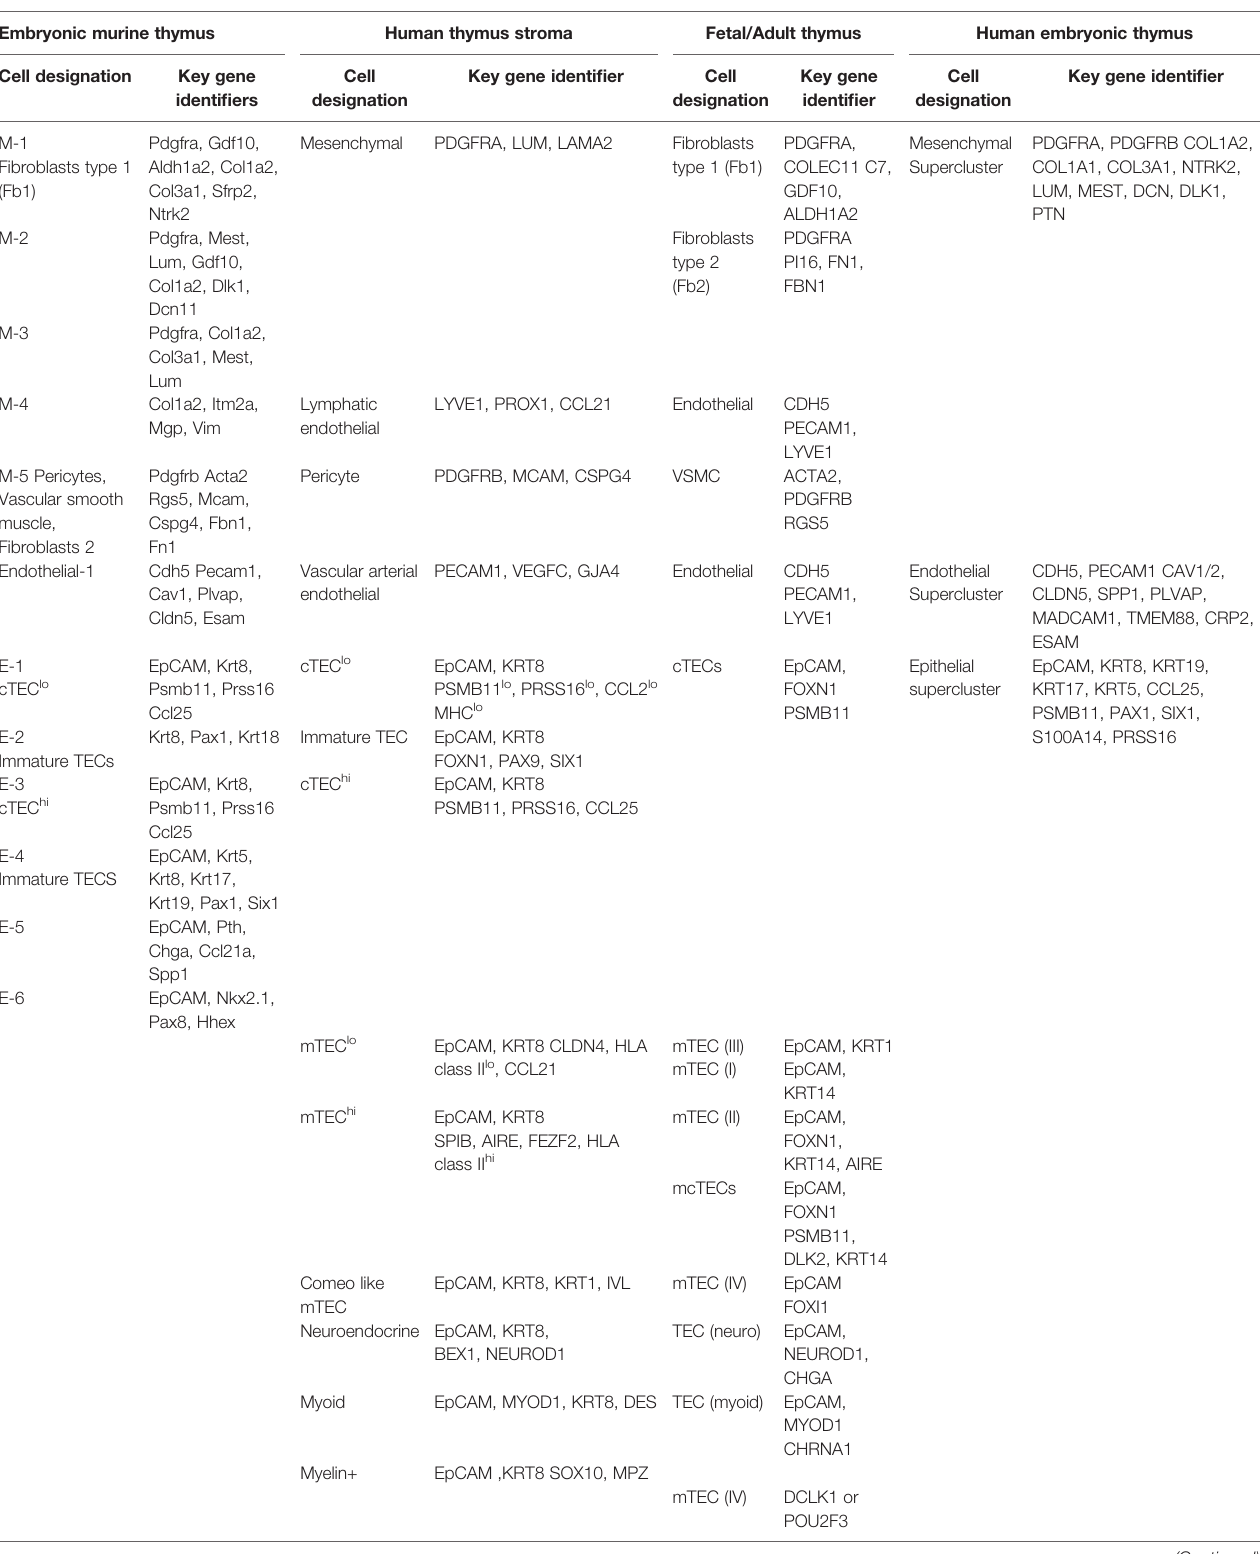
TABLE 2 | Distinct cell types in the thymus identi fi ed with single cell RNA sequencing. Embryonic murine thymus Human thymus stroma Fetal/Adult thymus Human embryonic